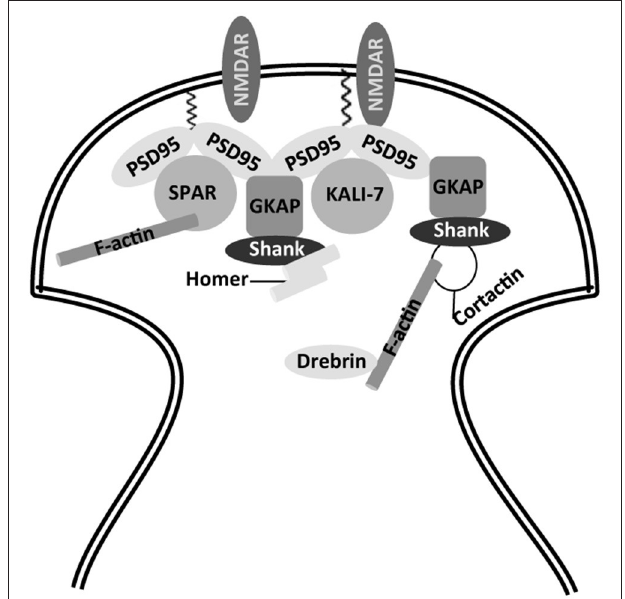
FIGURE 1 | Partial view of actin cytoskeleton in dendritic spines. Scaffold proteins involved in anchoring of NMDA receptors to actin cytoskeleton. NMDAR, N-methyl-D-aspartate receptor; PSD-95, post-synaptic density protein 95; GKAP, guanylate kinase-associated protein; Shank, SH3 and ankyrin repeat-containing protein; SPAR, spine-associated RapGAP; KALI-7, kalirin-7.